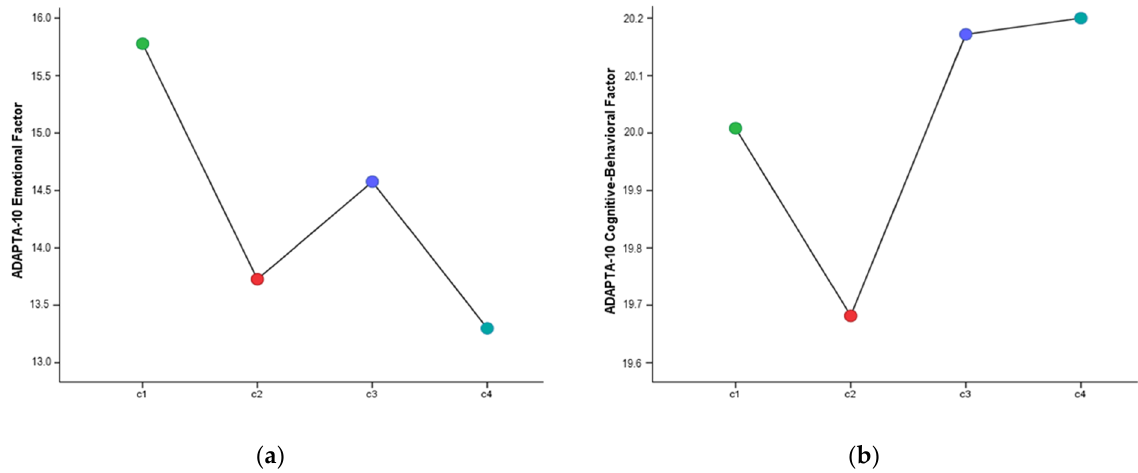
Figure 3. Adaptation to change by COVID-19 clusters. [Note: ( a ) Emotional Factor, ( b ) Cognitive–Behavioral Factor]. Table 4. Adaptation to change, by COVID-19 cluster. Descriptive statistics.